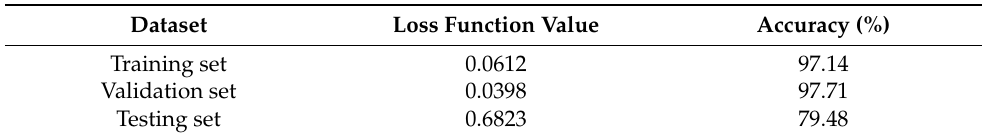
Table 6. Identification accuracy and loss for different